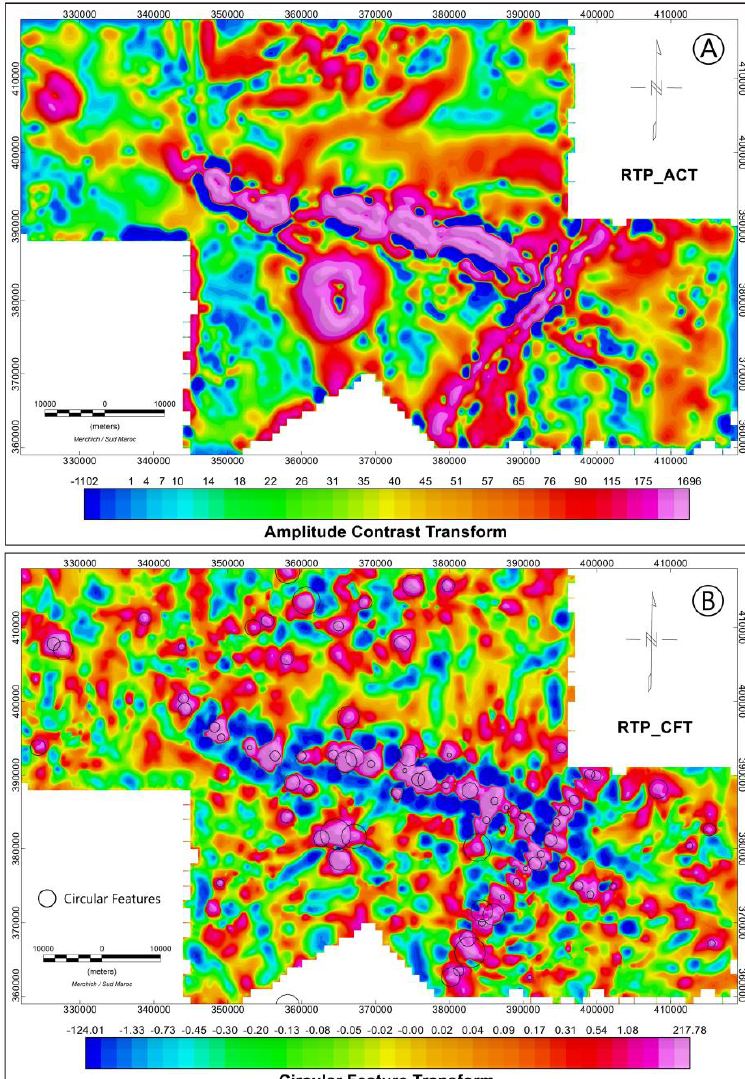
Figure 16. ( A ) Amplitude contrast transform map. ( B ) Circular feature transform map with contour- ing of the existent and probable porphyry.